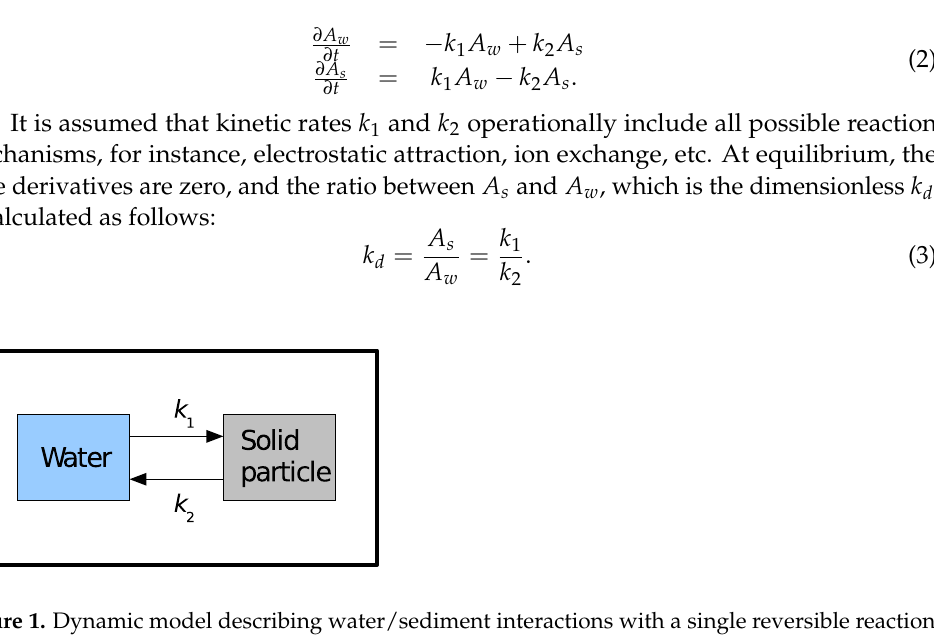
Figure 1. Dynamic model describing water/sediment interactions with a single reversible reaction. k 1 and k 2 are forward and backward kinetic